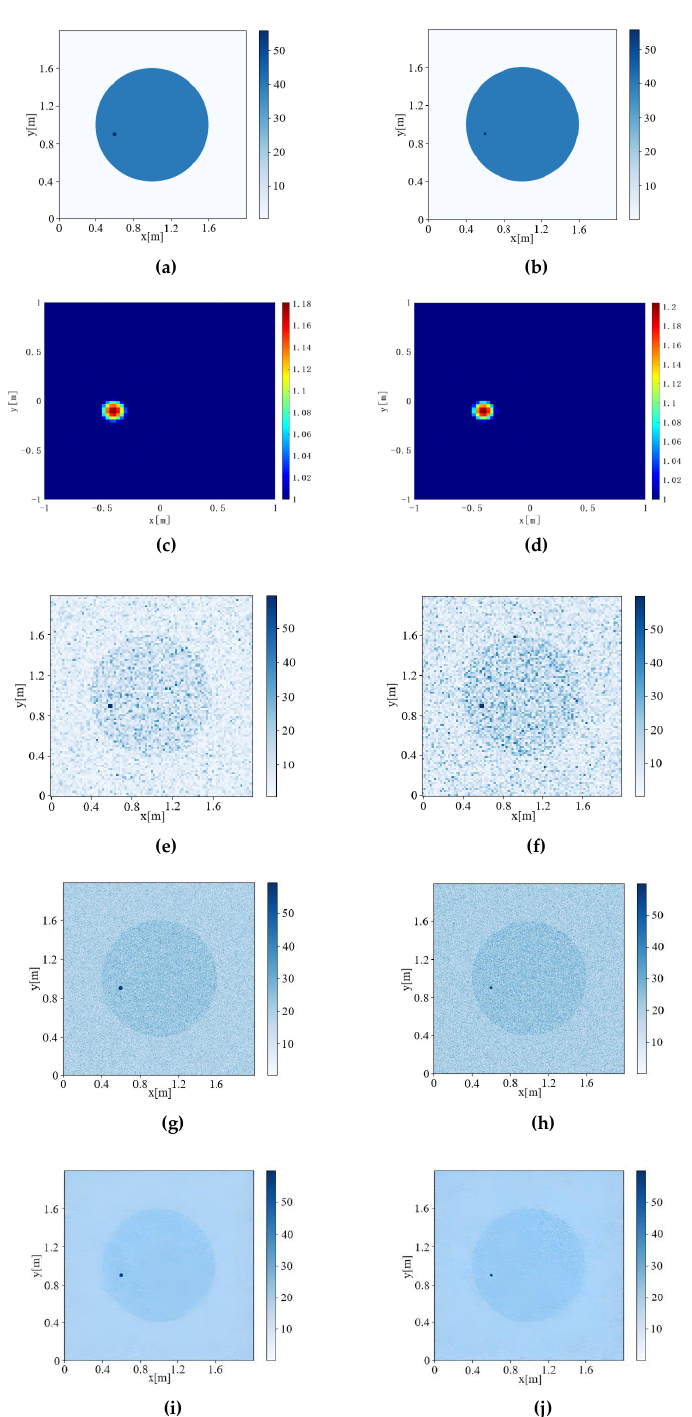
Figure 8. Inversion results of Inversion Ratio from 1:30 to1:40. ( a ) Model diagram of 𝐼𝑛𝑣𝑒𝑟𝑠𝑖𝑜𝑛 𝑅𝑎𝑡𝑖𝑜 = 1:30, ( b ) model diagram of 𝐼𝑛𝑣𝑒𝑟𝑠𝑖𝑜𝑛 𝑅𝑎𝑡𝑖𝑜 = 1:40, ( c ) Contrast Source Inversion results of 𝐼𝑛𝑣𝑒𝑟𝑠𝑖𝑜𝑛 𝑅𝑎𝑡𝑖𝑜 = 1:30, ( d ) Contrast Source Inversion results of 𝐼𝑛𝑣𝑒𝑟𝑠𝑖𝑜𝑛 𝑅𝑎𝑡𝑖𝑜 = 1:40, ( e ) Deep Convolutional Inversion results of 𝐼𝑛𝑣𝑒𝑟𝑠𝑖𝑜𝑛 𝑅𝑎𝑡𝑖𝑜 = 1:30, ( f) Deep Convolutional Inversion results of 𝐼𝑛𝑣𝑒𝑟𝑠𝑖𝑜𝑛 𝑅𝑎𝑡𝑖𝑜 = 1:40, ( g ) Joint-Driven inversion results of 𝐼𝑛𝑣𝑒𝑟𝑠𝑖𝑜𝑛 𝑅𝑎𝑡𝑖𝑜 = 1:30, ( h ) Joint driven inversion results of 𝐼𝑛𝑣𝑒𝑟𝑠𝑖𝑜𝑛 𝑅𝑎𝑡𝑖𝑜 = 1:40, ( i ) Joint-Driven Super-resolution inversion re- sults of 𝐼𝑛𝑣𝑒𝑟𝑠𝑖𝑜𝑛 𝑅𝑎𝑡𝑖𝑜 = 1:30, and ( j ) Joint-Driven Super-resolution inversion results of 𝐼𝑛𝑣𝑒𝑟𝑠𝑖𝑜𝑛 𝑅𝑎𝑡𝑖𝑜 = 1:40.